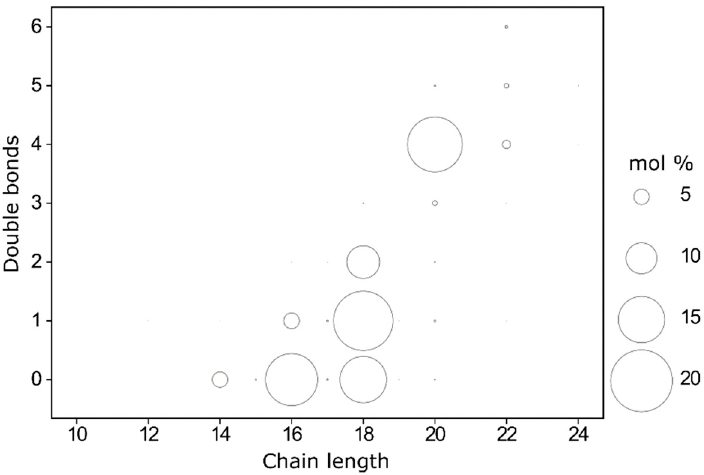
Figure 2. Lipid composition of the plasma membrane of resting platelets with ( a ) Phosphatidylcholines (PC), ( b ) Phospha- tidylethanolamines ether (PE O-), ( c ) Sphingomyelins (SM), ( d ) Phosphatidylethanolamines (PE), ( e ) Phosphatidylserines (PS), ( f ) Phosphatidylcholines ether (PC O-) and ( g ) Phosphatidylinositols (PI). Results are expressed in mol% inside each sub-class of lipids. Lipids below 2% of its sub-classes were not represented. Complete values are available in supplemen- tary data (Table S1).